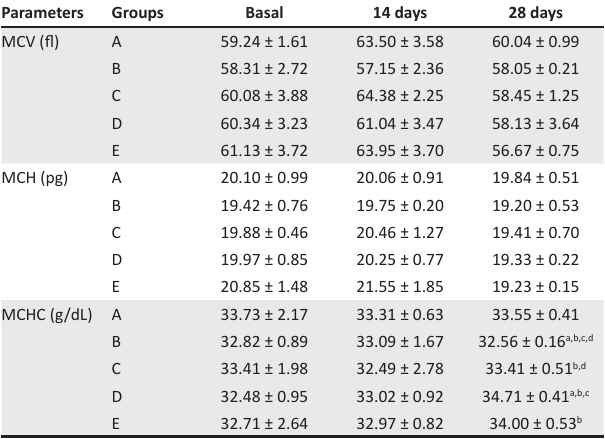
TABLE 7: Effects of Vernonia amygdalina on white blood cell differentials count of alloxan-induced diabetic rats. Parameters